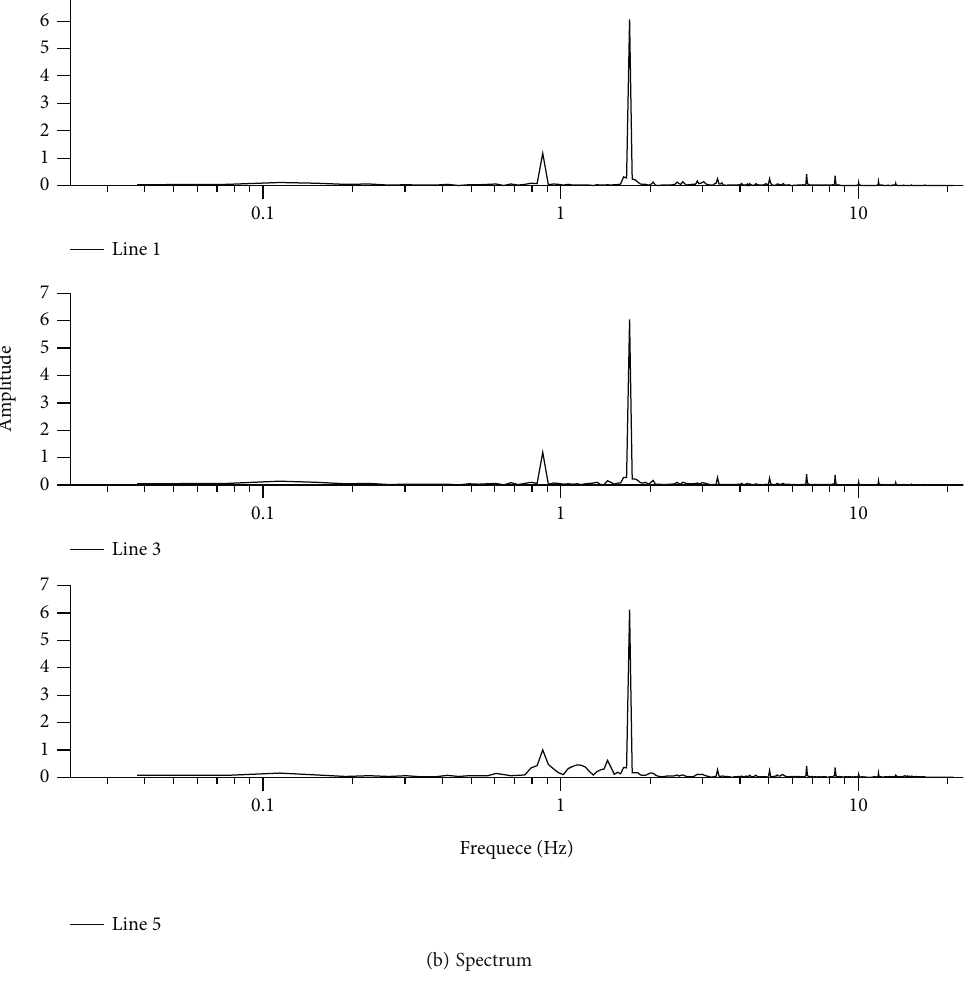
Figure 11: Acceleration curve of